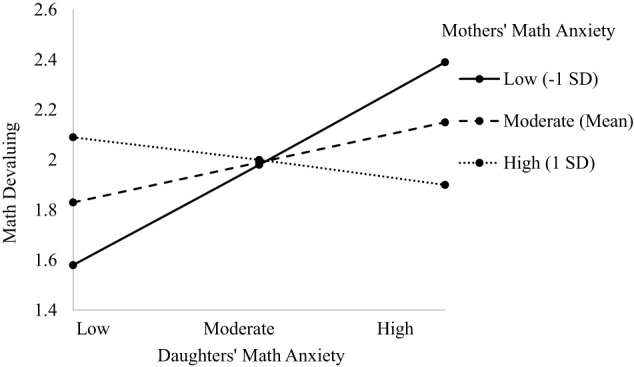
Three-way interaction predicting math devaluing from Mothers' and Daughters' math anxiety.